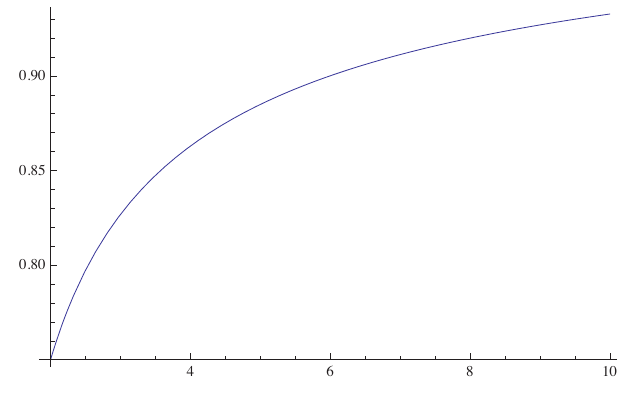
Figure 1: The function γ for 2 < p < 10. In[41]:= Plot